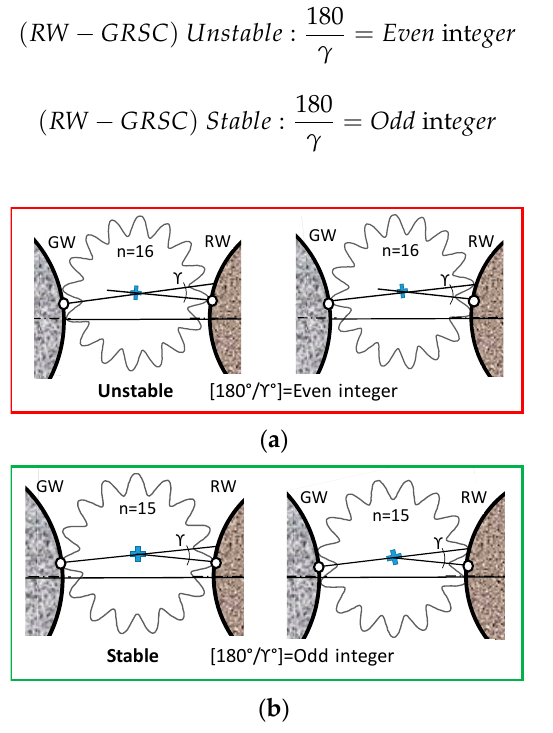
Figure 10. Regulating wheel (RW) geometrical rounding stability criteria. ( a ) RW geometrical rounding unstable conditions; ( b ) RW geometrical rounding stable conditions.